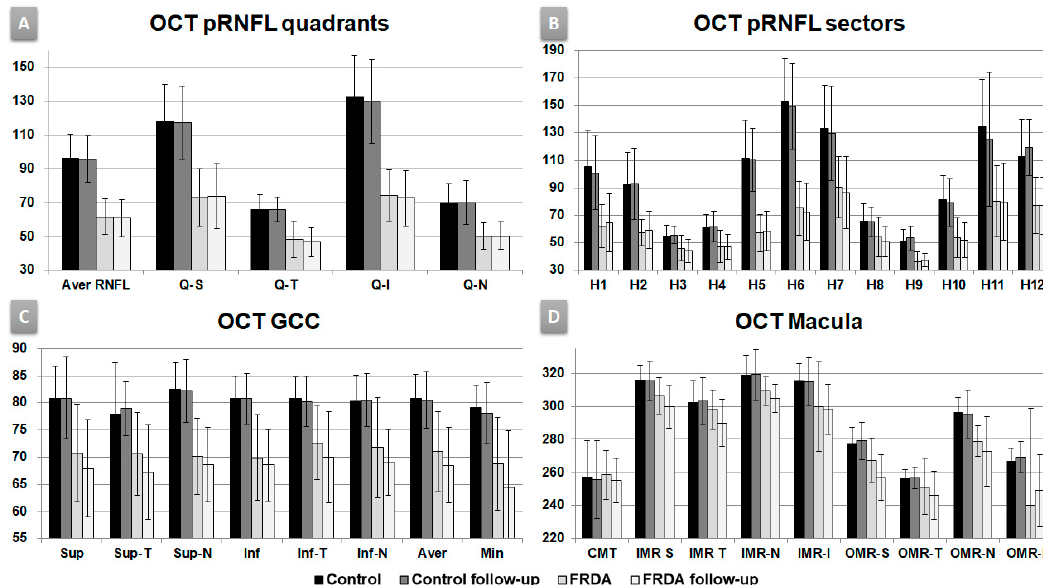
Figure 1. Optic coherence tomography outcomes, follow-up study. Vertical axis in microns. ( A ) OCT